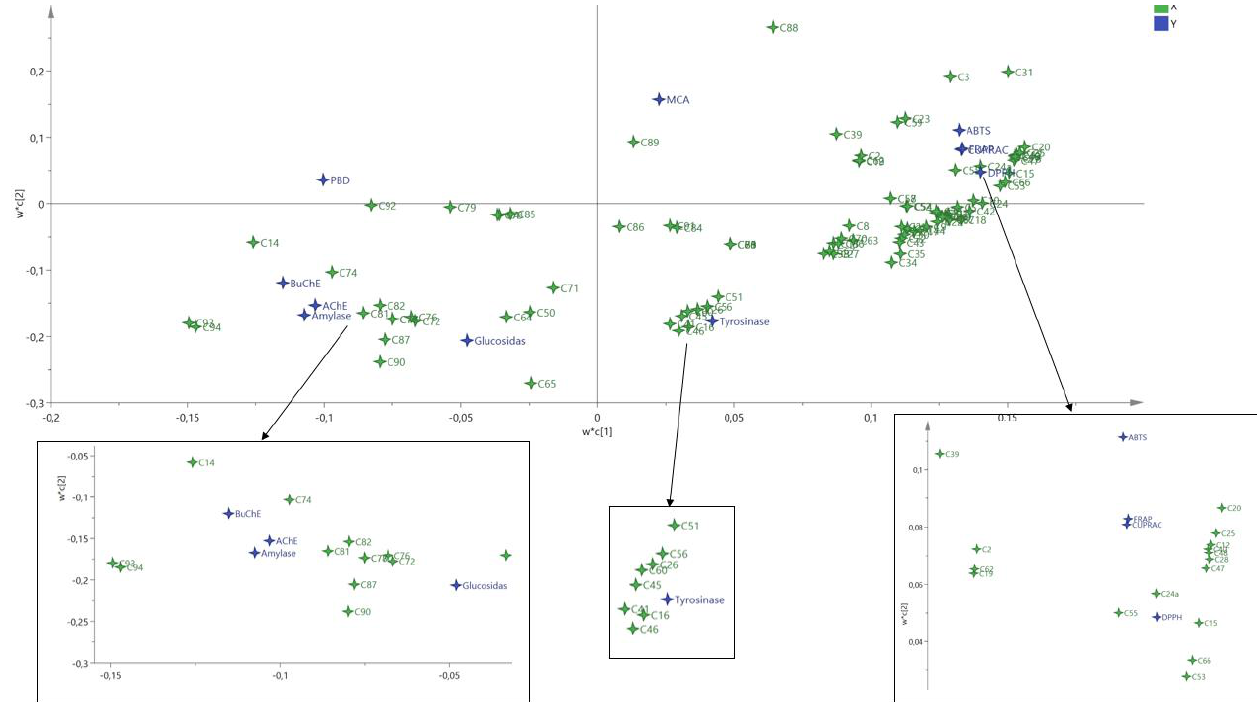
Figure 5. The loading plot obtained from Partial least squared regression describing relationship between chemical molecules and biological activities. (C1) protocatechuic acid-O-hexoside, (C2) caffeoylgluconic acid, (C3) protocatechuic acid, (C4) p-hydroxyphenylacetic acid-O-hexoside, (C5) protocatechuic acid-O-hexoside isomer, (C6) syringic acid 4-O-hexoside (C7) neochlorogenic (3-caffeoylquinic) acid, (C8) caffeoylgluconic acid isomer, (C9) caffeic acid-O-hexoside, (C10) gentisic acid-O-hexoside, (C11) vanillic acid 4-O-hexoside, (C12) caffeoylgluconic acid isomer, (C13) O-caffeoyl hexose isomer, (C14) 4-hydroxybenzoic acid, (C15) 4-hydroxybenzoic acid-hexoside, (C16) p-hydroxyphenylacetic acid O-hexoside, (C17) quinic acid, (C18) chlorogenic (5-caffeoylquinic) acid, (C19) p-coumaric acid, (C20) 3-feruloylquinic acid, (C21) p-hydroxyphenylacetic acid, (C22) caffeic acid, (C23) gentisic acid, (C24) 5-p-coumaroylquinic acid, (C24a) 1,3-dicaffeoylquinic acid, (C25) caffeic acid-O-hexoside isomer, (C26) 5-feruloylquinic acid, (C27) m-coumaric acid, (C28) 5-p-coumaroylquinic acid isomer, (C29) 4-feruloylquinic acid, (C30) vanillic acid, (C31) o-coumaric acid, (C32) vanillic acid-4-O-(6-O-caffeoyl)-hexoside, (C33) 3,4-dicaffeoylquinic acid, (C34) 1,5-dicaffeoylquinic acid, (C35) 3,5-dicaffeoylquinic acid, (C36) dicaffeoyl-tetrahydroxy-pentanoic acid, (C37) 4,5-dicaffeoylquinic acid, (C38) shikimic acid, (C39) salicylic acid, (C40) 3-feruloyl-4-caffeoylquinic acid, (C41) 3-p-coumaroyl-5-caffeoylquinic acid, (C42) caffeic acid-O-(salicyl)-hexoside, (C43) 3-feruloyl-5-caffeoylquinic acid, (C44) 4-p-coumaroyl-5-caffeoylquinic acid, (C45) 1-caffeoyl-3-feruloylquinic acid, (C46) 3,4,5-tricaffeoylquinic acid, (C47) 6, 8-diC-hexosidyl-luteolin, (C48) O,C-dihexosyl-luteolin, (C49) diC-hexosyl-apigenin, (C50) 6-C-hexosyl-8-C-pentosyl- luteolin, (C51) 2”-O-pentosyl-6-C-hexosyl-luteolin, (C52) homoorientin, (C53) 6-C-hexosyl-8-C-pentosyl apigenin, (C54) orientin (luteolin-8-C-glucoside), (C55) C-hexosyl-C-pentosyl methylluteolin, (C56) rutin, (C57) vitexin, (C58) isovitexin, (C59) 2”-O-pentosyl-6-C-hexosyl-methylluteolin, (C60) Luteolin-7-O-glucosidea, (C61) chrysoeriol-6-C-hexoside, (C62) nepetin-O-hexuronide, (C63) 6-methoxykaempferol-O-hexoside, (C64) nepetin-O-hexoside, (C65) kaempferol-3-O-glucoside, (C66) isorhamnetin 3-O-glucoside, (C67) apigenin-7-O-glucoside, (C68) cirsiliol-O-hexoside, (C69) chrysoeriol-O-hexuronide, (C70) jaceosidin-O-hexuronide, (C71) luteolin, (C72) quercetin, (C73) patuletin (6-methoxyquercetin), (C74) axillarin, (C75) apigenin, (C76) kaempferol, (C77) hispidulin (scutellarein-6-